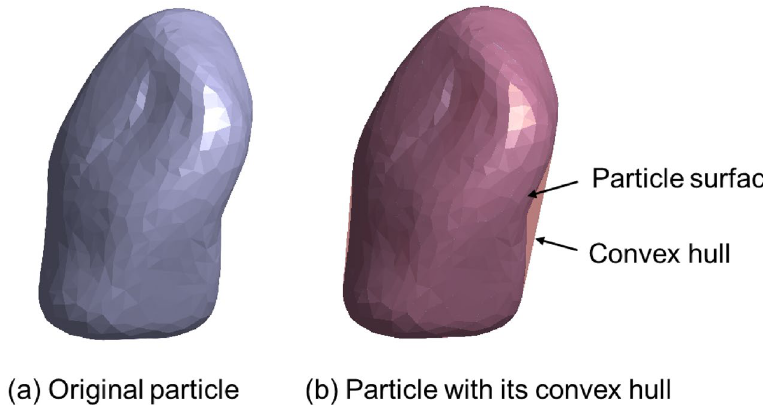
Fig. 9 Illustration of convex